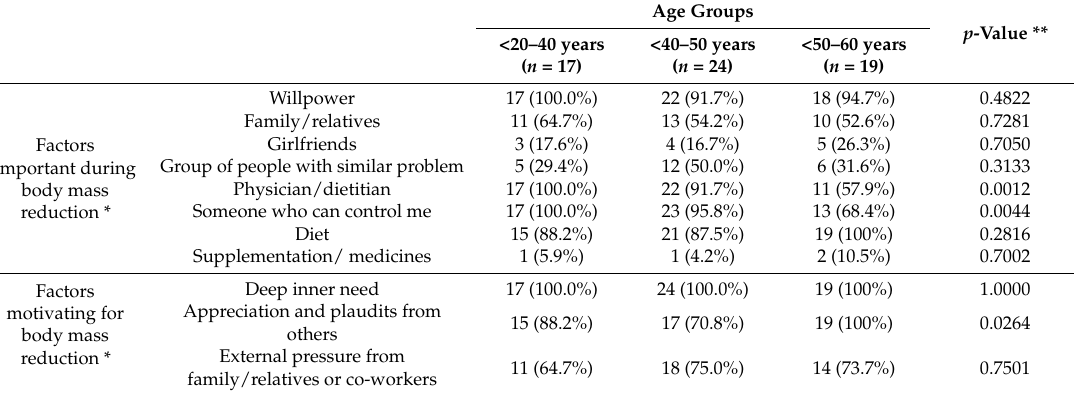
Table 7. The motivation towards body mass reduction in the studied group for the sub-groups stratified by